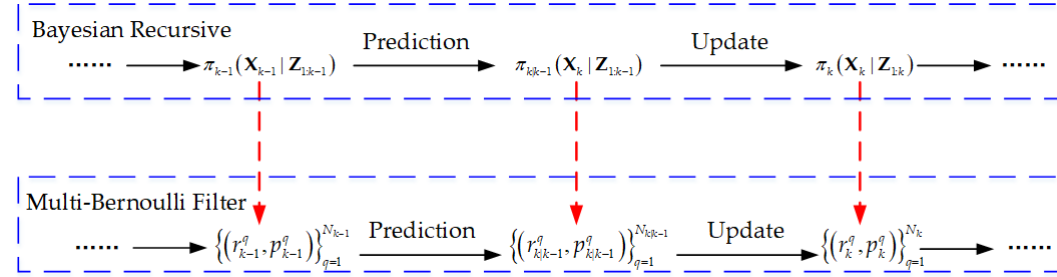
Figure 3. Propagation track table in Bayesian recursive and multi-Bernoulli filter.